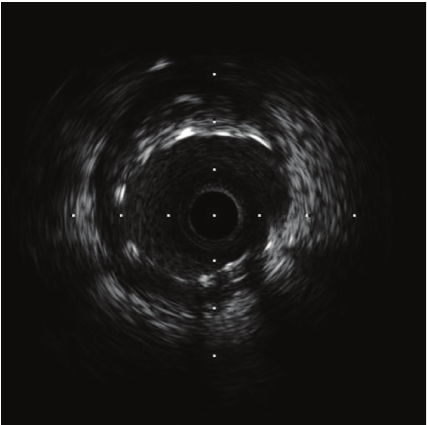
Figure 1: Anterior-posterior cranial view showed the significant stenosis of the proximal portion of the second diagonal branch before percutaneous coronary intervention.